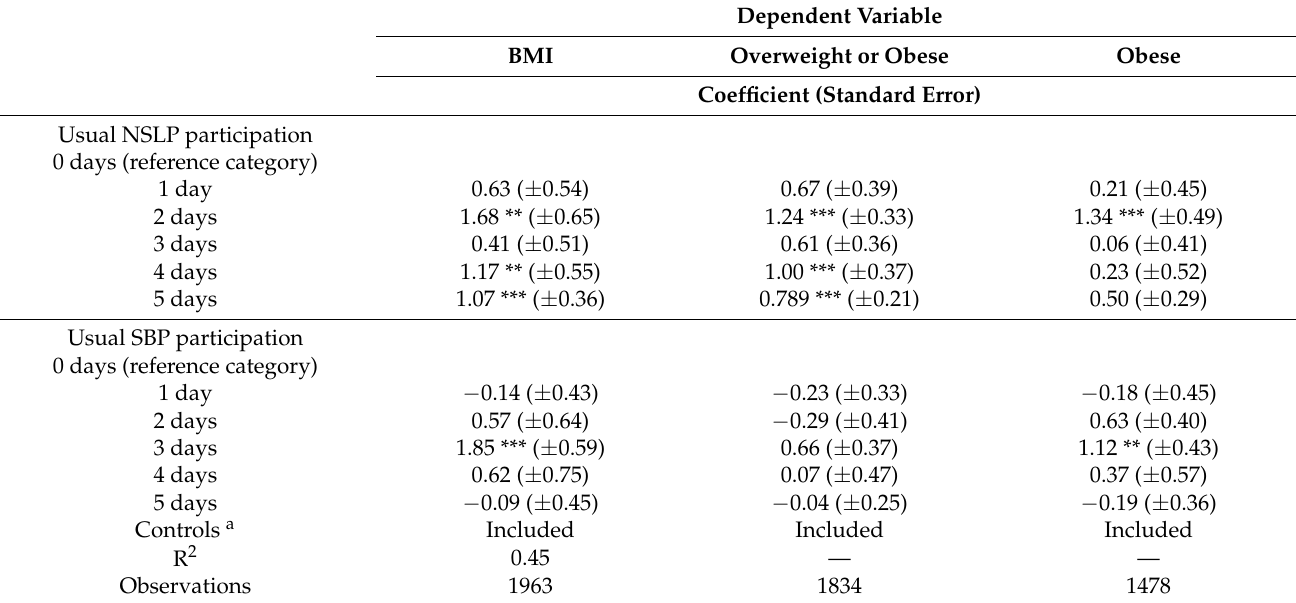
Table 5. Estimated association between SBP and NSLP participation on BMI,